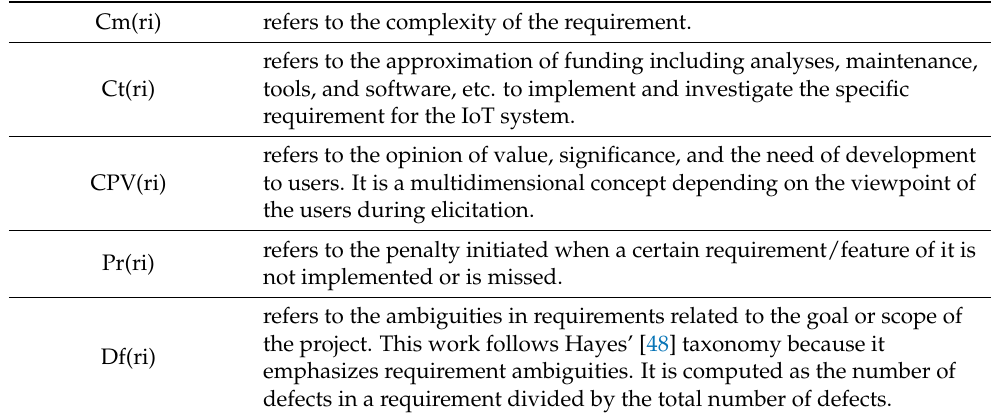
Table 2. Risk estimation